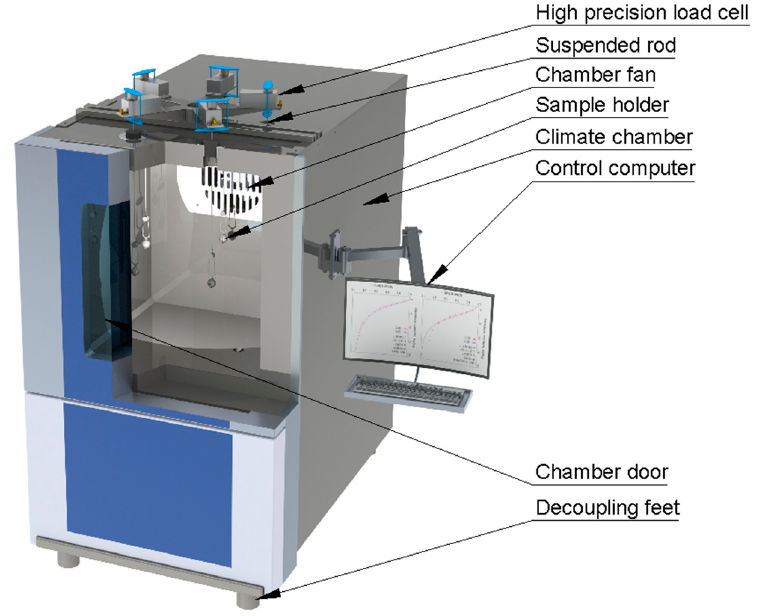
Figure 1. Cutaway view of automated system for dynamic vapor sorption recording.